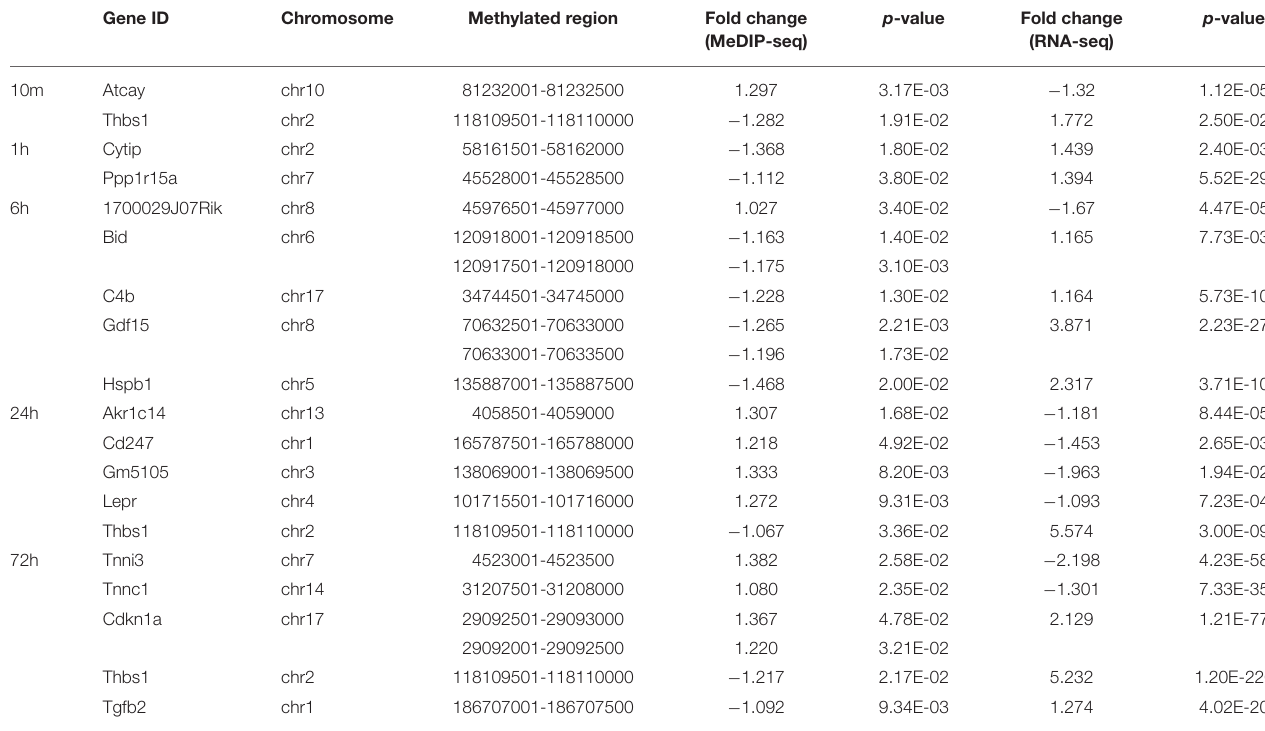
TABLE 1 | Promoter methylation of DMEGs. Gene ID Chromosome Methylated region Fold change